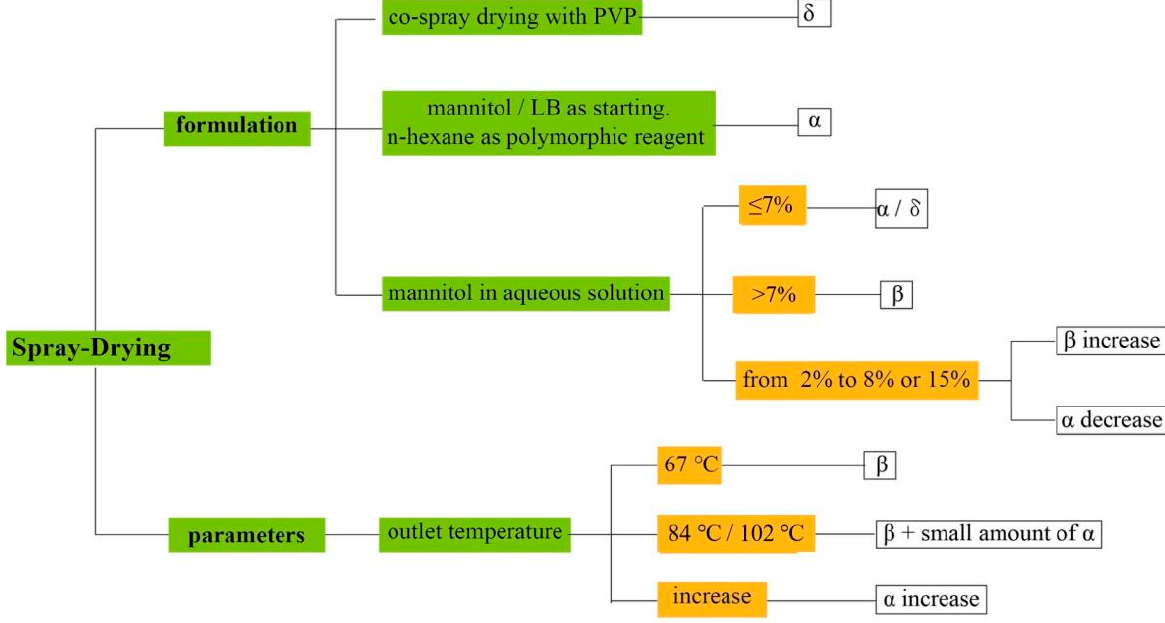
Figure 9. Schematic of spray-drying method for the preparation of polymorphic mannitol.